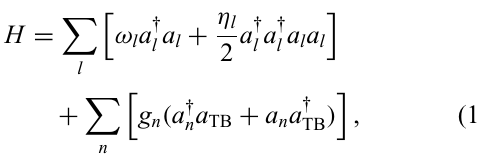
(cid:2) is used), Q 1 2